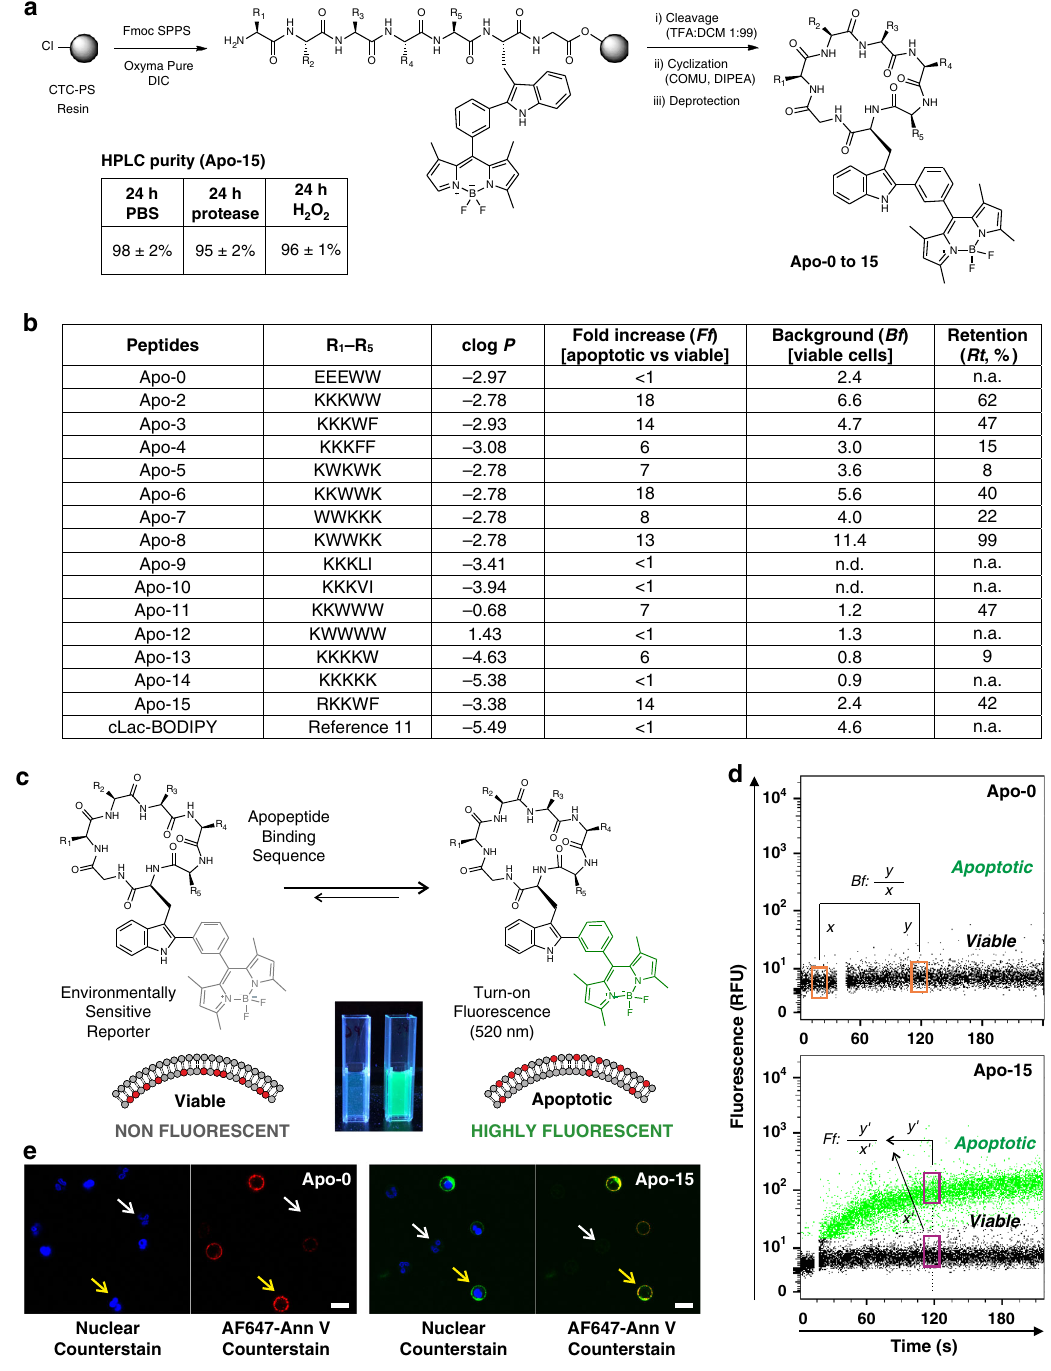
Fig. 1 Design, synthesis, and in vitro screening of apopeptides. a Synthetic scheme for the preparation of apopeptides (CTC-PS: 2-chlorotritylchloride polystyrene resin). Stability analysis of Apo-15 (50 μ M) under different proteolytic and oxidative environments. b Sequences, physicochemical and binding properties of apopeptides and cLac-BODIPY. In vitro screening of the peptides (100 nM) was performed by real-time fl ow cytometry in mixtures of apoptotic (AF647-Annexin V positive) and viable (AF647-Annexin V negative) neutrophils ( n ≥ 3, biologically independent experiments). c Fluorescence